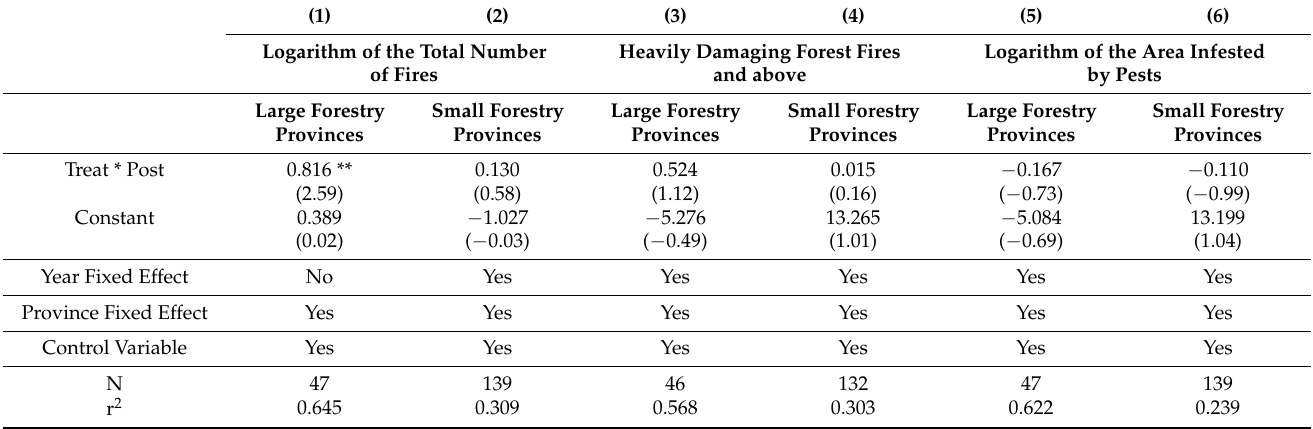
Table 10. Fixed effects regression model results: large forestry provinces vs. small forestry